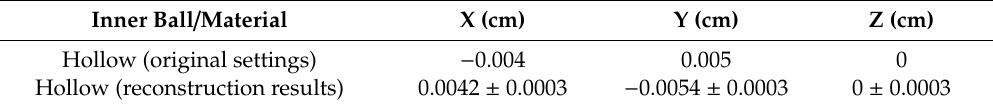
Figure 3. ( a ) The sample structures model, aluminum ball (big and red), and inner hollow ball (small and blue), ( b ) the conceptual projection showing the inner hollow small ball reverse image in x - y plane, the HEER image of the sample with ( c ) 0-degree rotation and ( d ) 179-degree rotation in simulation. Table 3. The reconstructed inner ball x , y , and z positions compared with original settings. Inner Ball /